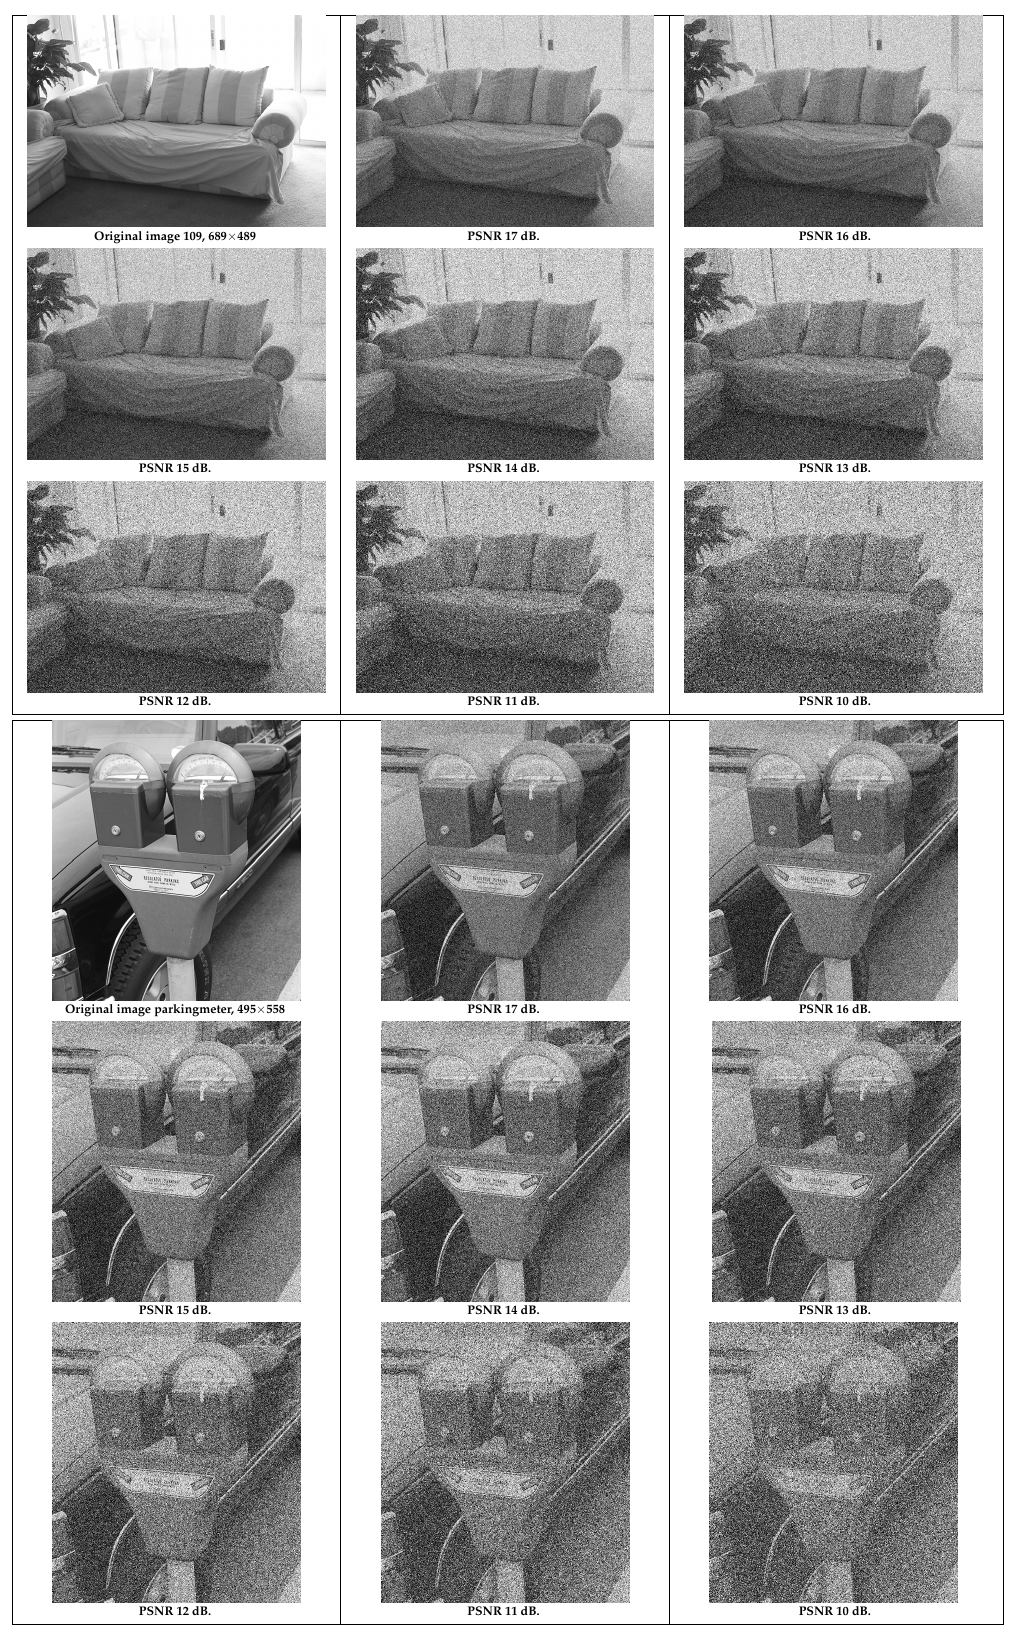
Figure 17. Image 109 ( top ) and image "parkingmeter" ( bottom ) at different levels of noise